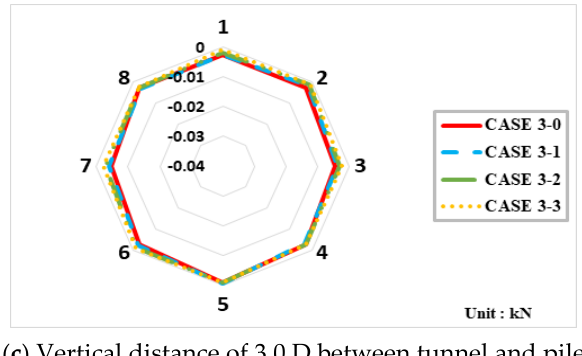
Figure 13. Axial force on tunnel by allowable load in model test.